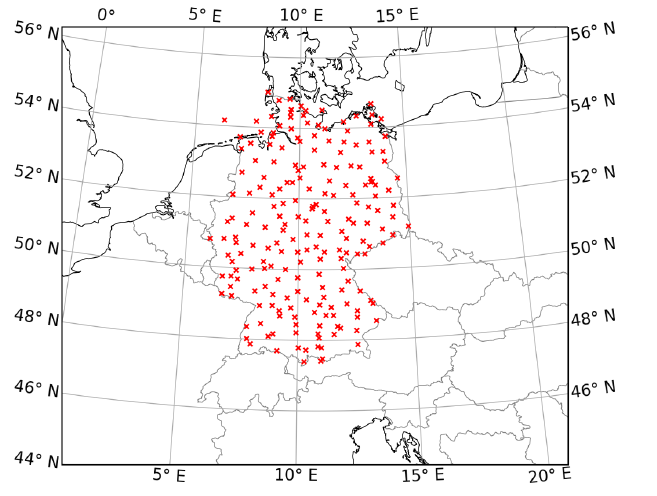
Figure B2. Location of the 206 DWD ground stations providing si- multaneous measurements of surface values of T , p , and RH during May to June 2018.